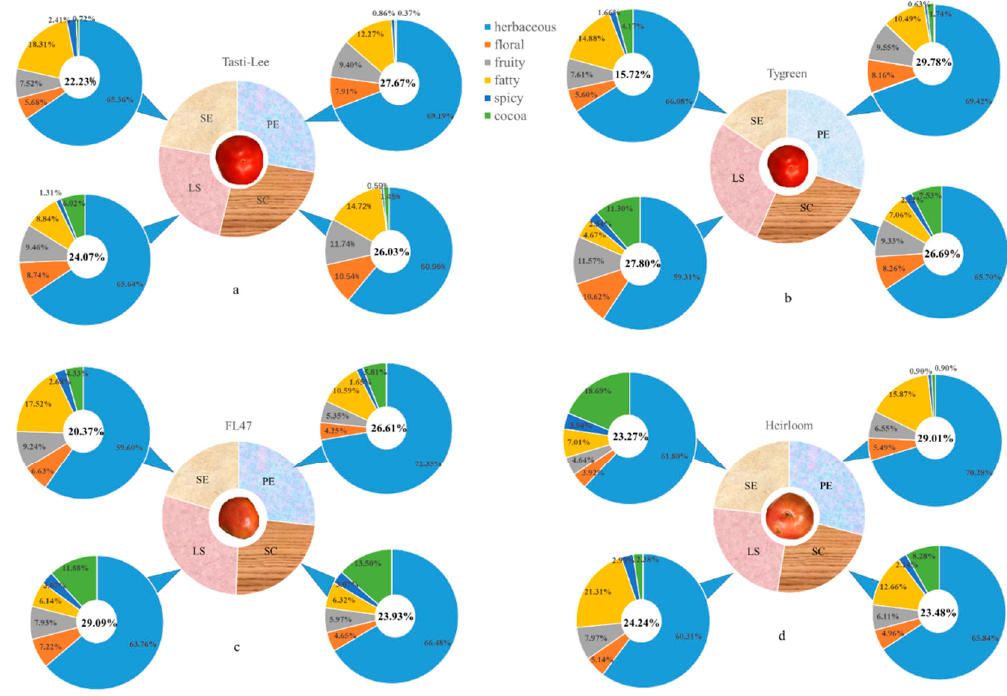
Figure 2. Aromatic proportion and aromatic series per tissue in tomatoes. ( a ) “Tasti-Lee”, ( b ) “Tygress”, ( c ) “FL47”, and ( d ) “Cherokee Purple”.